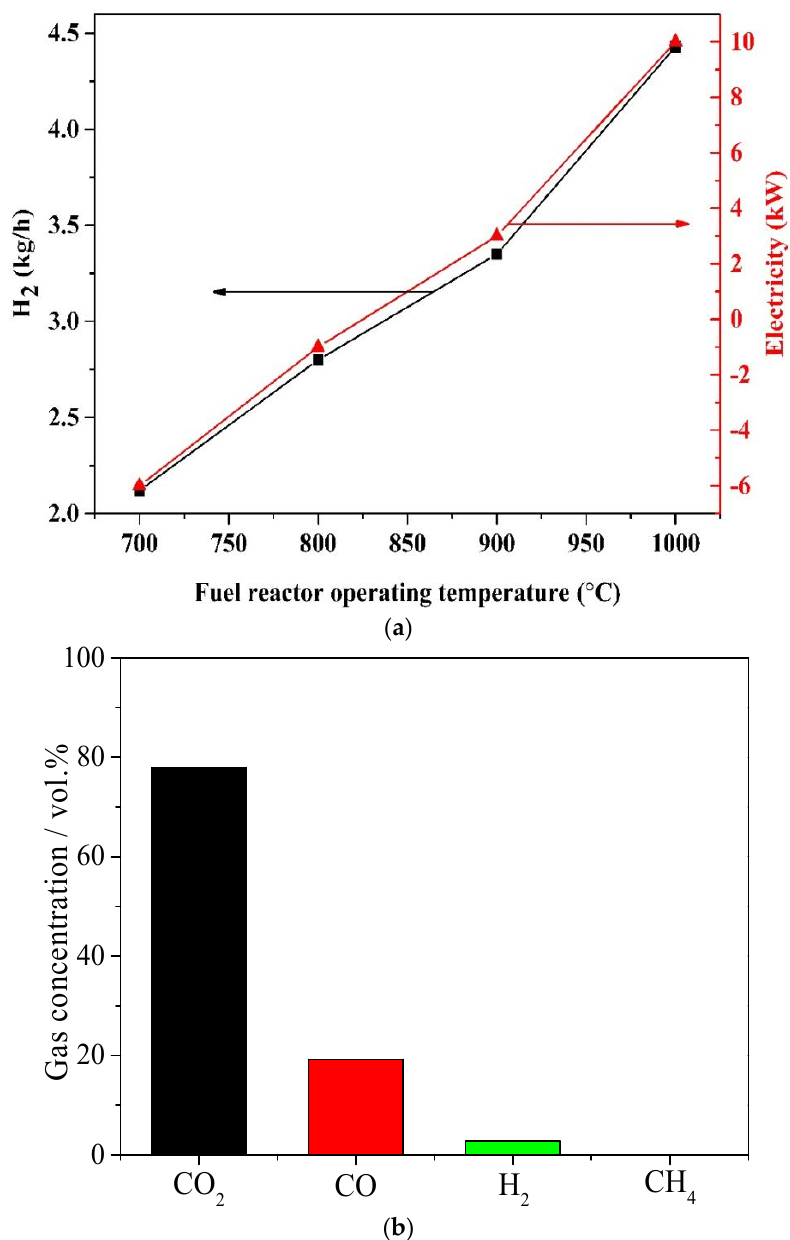
Figure 4. Influence of the fuel reactor operating temperature, the temperatures of pyrolysis reactor, steam reactor and air reactor are 500 ◦ C, 700 ◦ C and 980 ◦ C. ( a ) Hydrogen and electricity production. ( b ) The gas composition of the outlet of fuel reactor at 900 ◦